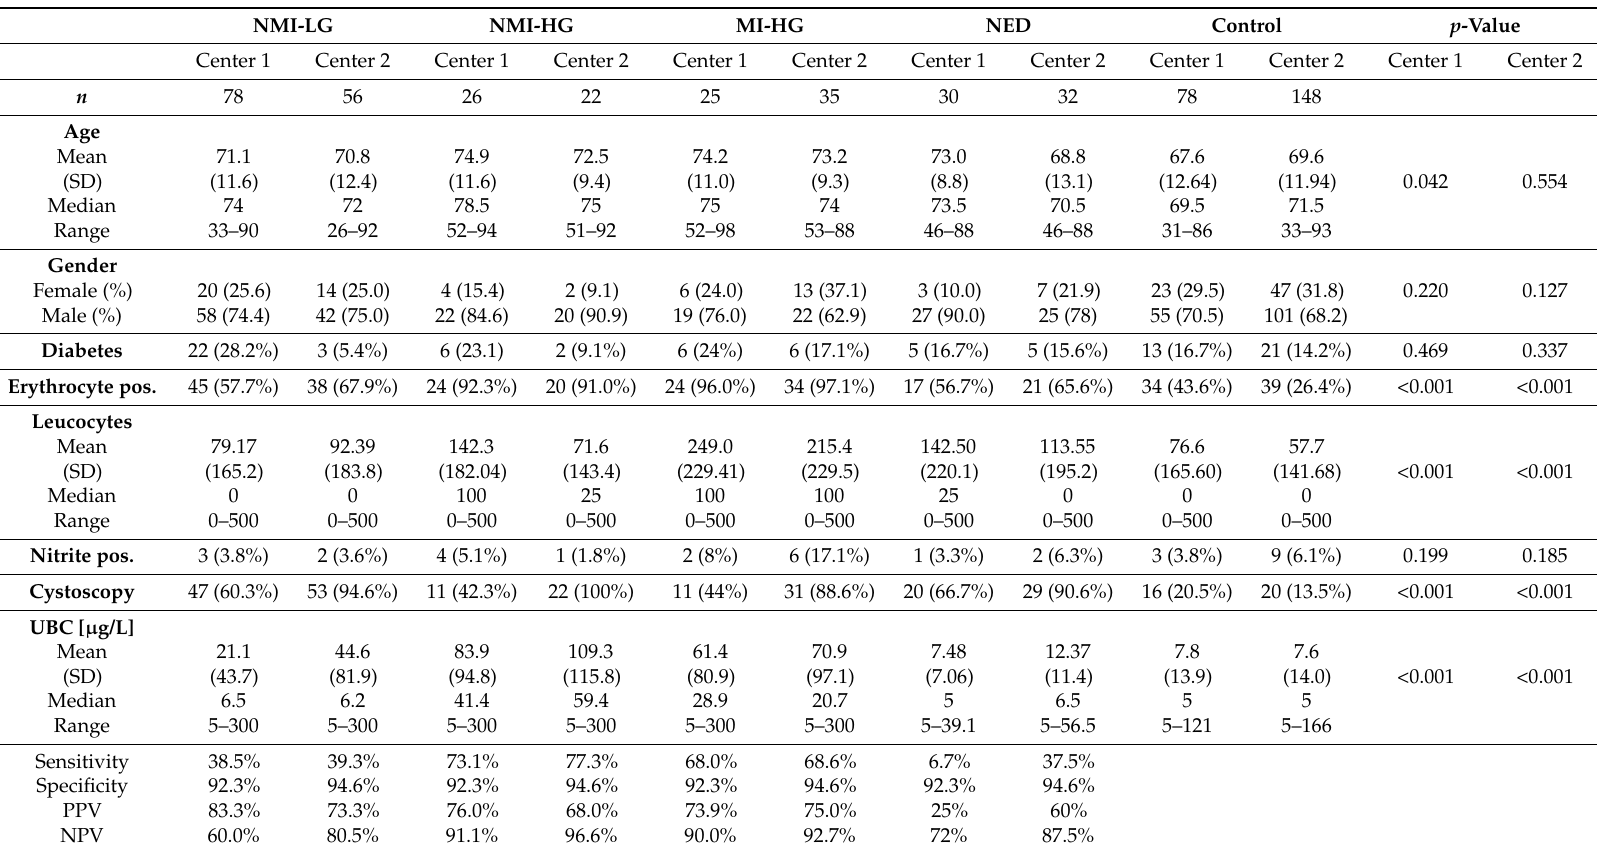
Table 2. Patient characteristics and results of UBC ® Rapid separated for center 1 and center